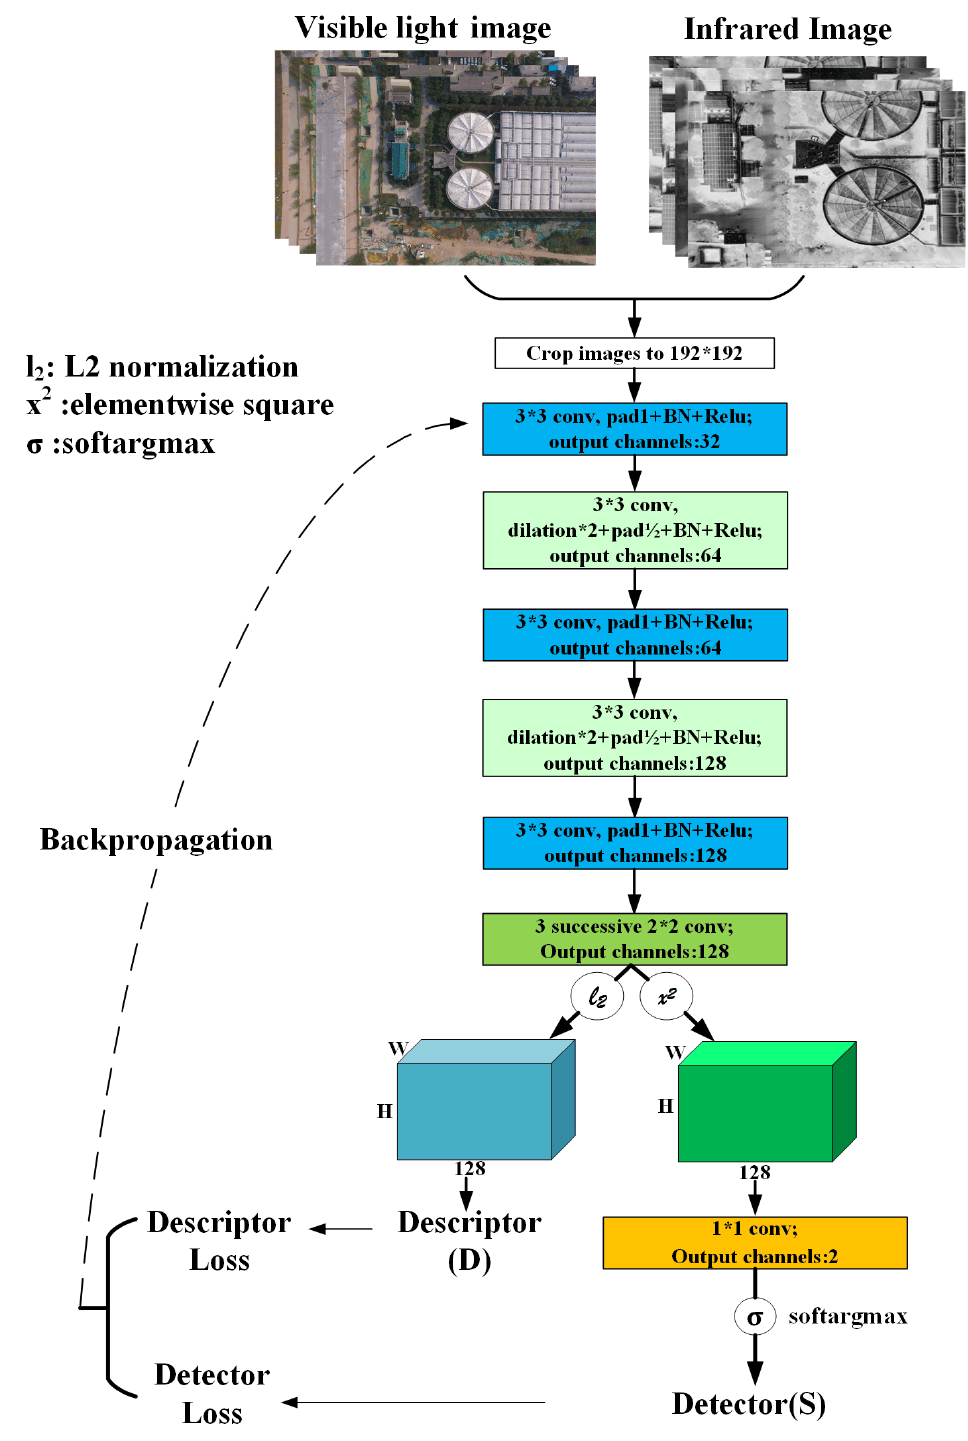
Figure 4. Overview of the network